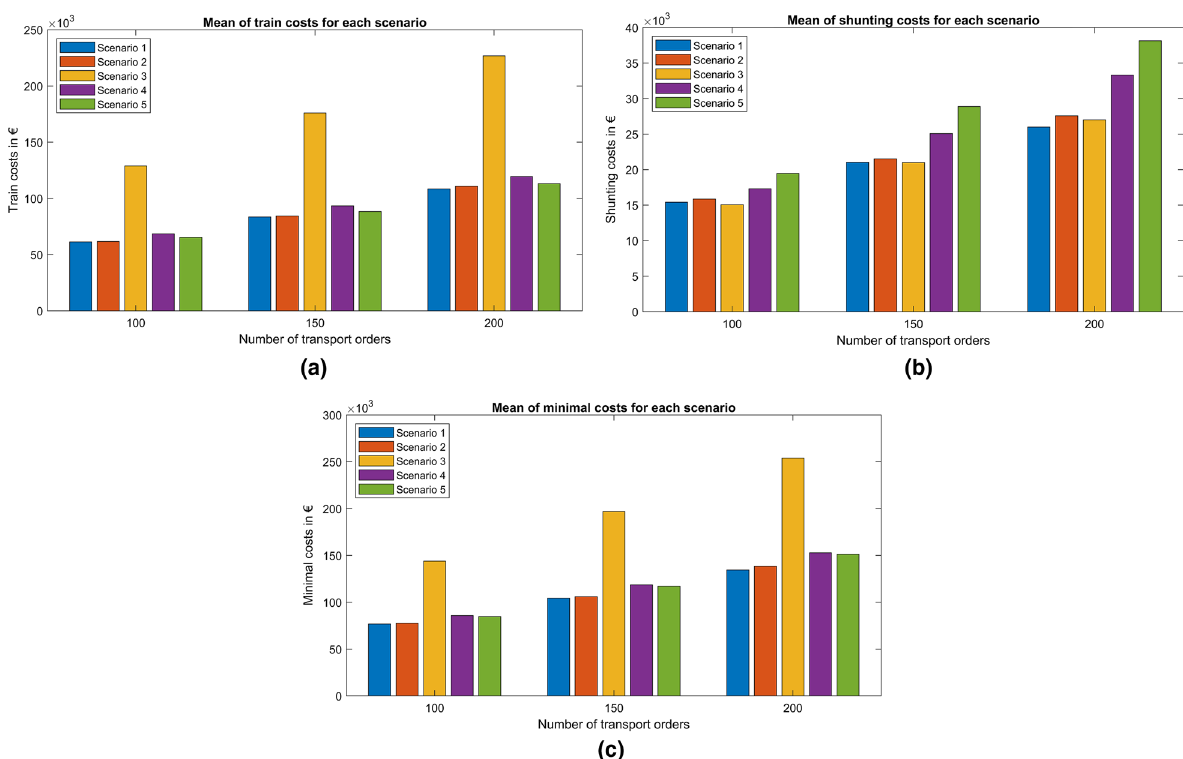
Fig. 4 Mean train, shunting and total costs for each scenario, instance and test